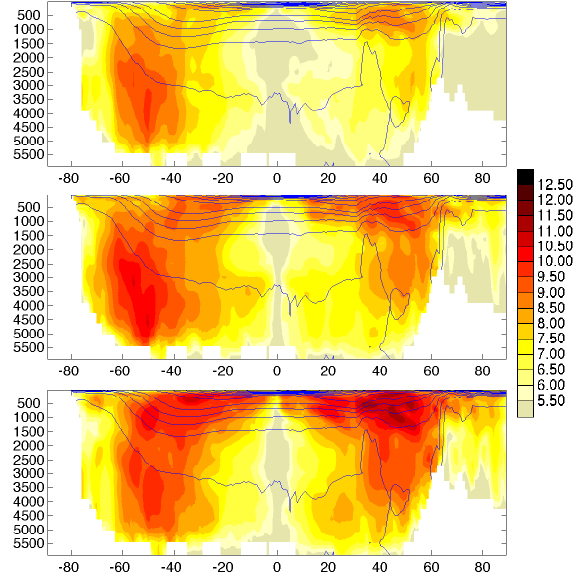
Figure 5. Sensitivity to K gm associated with 1992–2001 altime- try (top), 1992–2011 altimetry (middle), and Argo T and S pro- files (bottom). More than 98% of Argo profiles were collected af- ter 2001. In each case, the squared model–data distance J is se- is computed with the adjoint model. lected accordingly, and ∂J ∂ K gm The adjoint model and J Argo are documented in details in For- get et al. (2015). For altimetry, J uses the large-scale formula- tion of Forget and Ponte (2015). In all cases, all turbulent trans- port parameters are reset to their unadjusted values, so that the ad- joint computation is representative of the starting point of the es- timation process. The results are displayed non-dimensionally as || 2 ) where || . || 2 denotes the zonal mean squared log 10 ( || u gm ∂J ∂ K gm norm, and u gm = 500m 2 s − 1